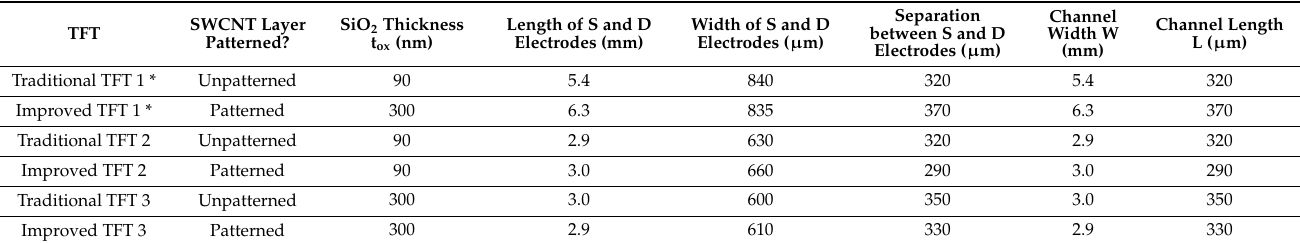
Table 1. The critical dimensions of each of our